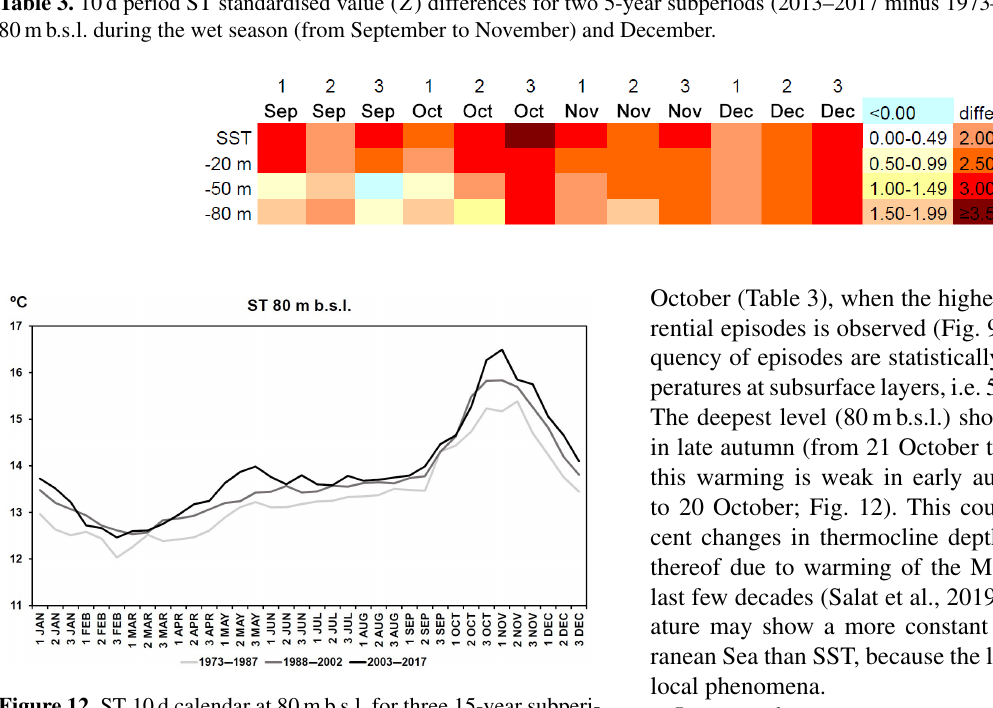
Figure 12. ST 10d calendar at 80mb.s.l. for three 15-year subperi- ods: 1973–1987, 1988–2002 and